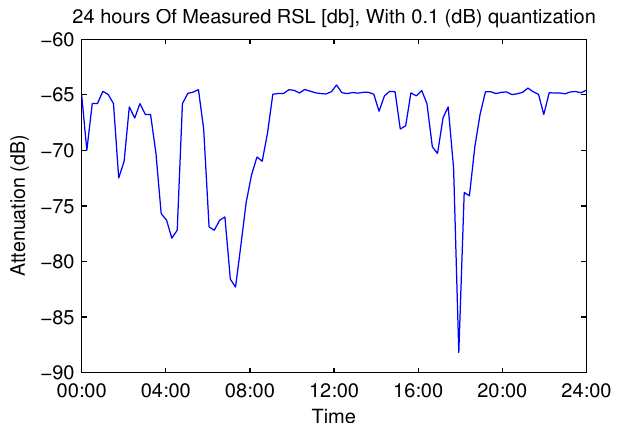
Figure 2. Example of 24h of measured RSL (dB), during a rain Fig. 2. Example of 24 hours of measured RSL ( dB ), during a rain event which occurred on 07-January-2013, event which occurred on 7 January 2013, for a single 14km link for a single 14 km link, operating at a frequency of 21.8 GHz . operating at a frequency of 21.8GHz.